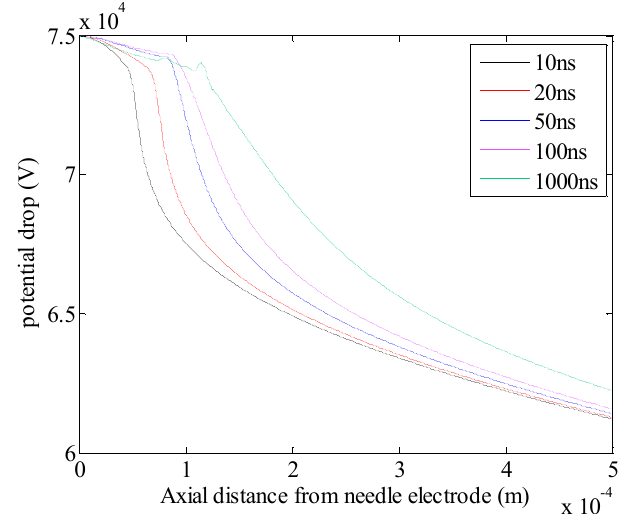
Figure 11. Potential drop along the needle-sphere axis as a response to 1.5 PDIV with 10 mm needle-sphere electrode configuration.